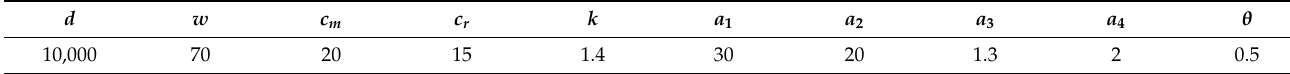
Table 3. Design of relevant parameters.